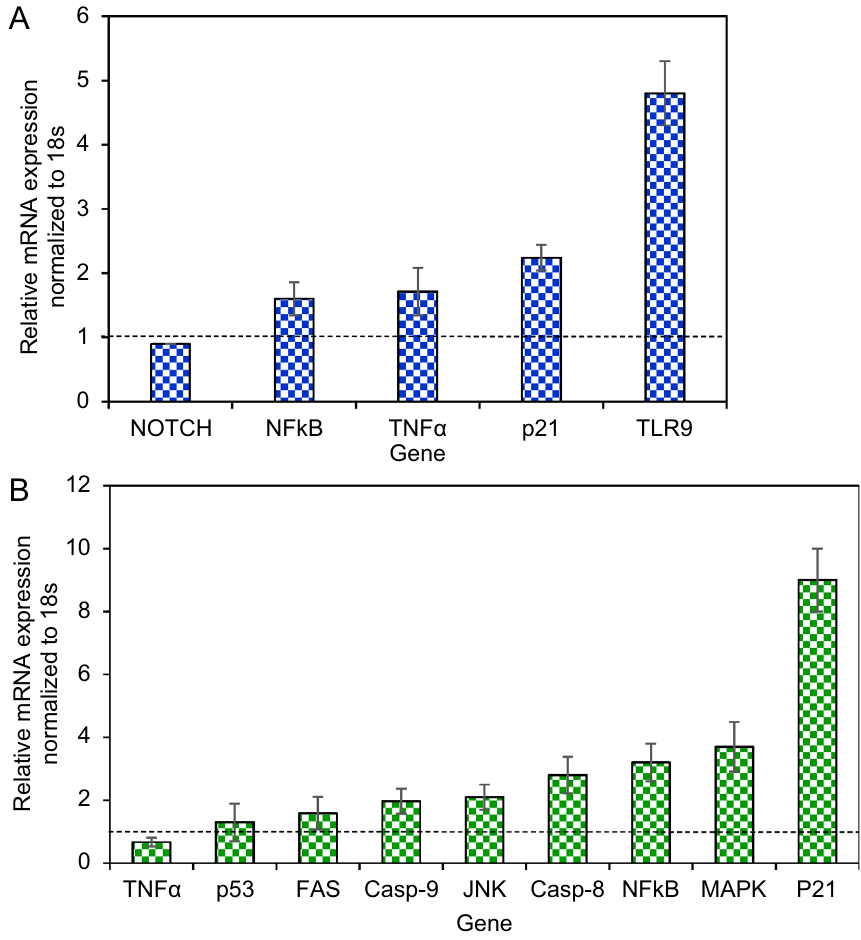
Figure 5. Assessment of genes expression in GSCs and MCF-7 cells. After treatment of GSCs ( A ) and MCF-7 ( B ) with G. densiflorum -Ag/AgCl-NPs, changes of genes expiration were analyzed by the Double Delta CT method. The data were normalized using the 18 s gene. A dashed line (black) indicates 1.0 expression